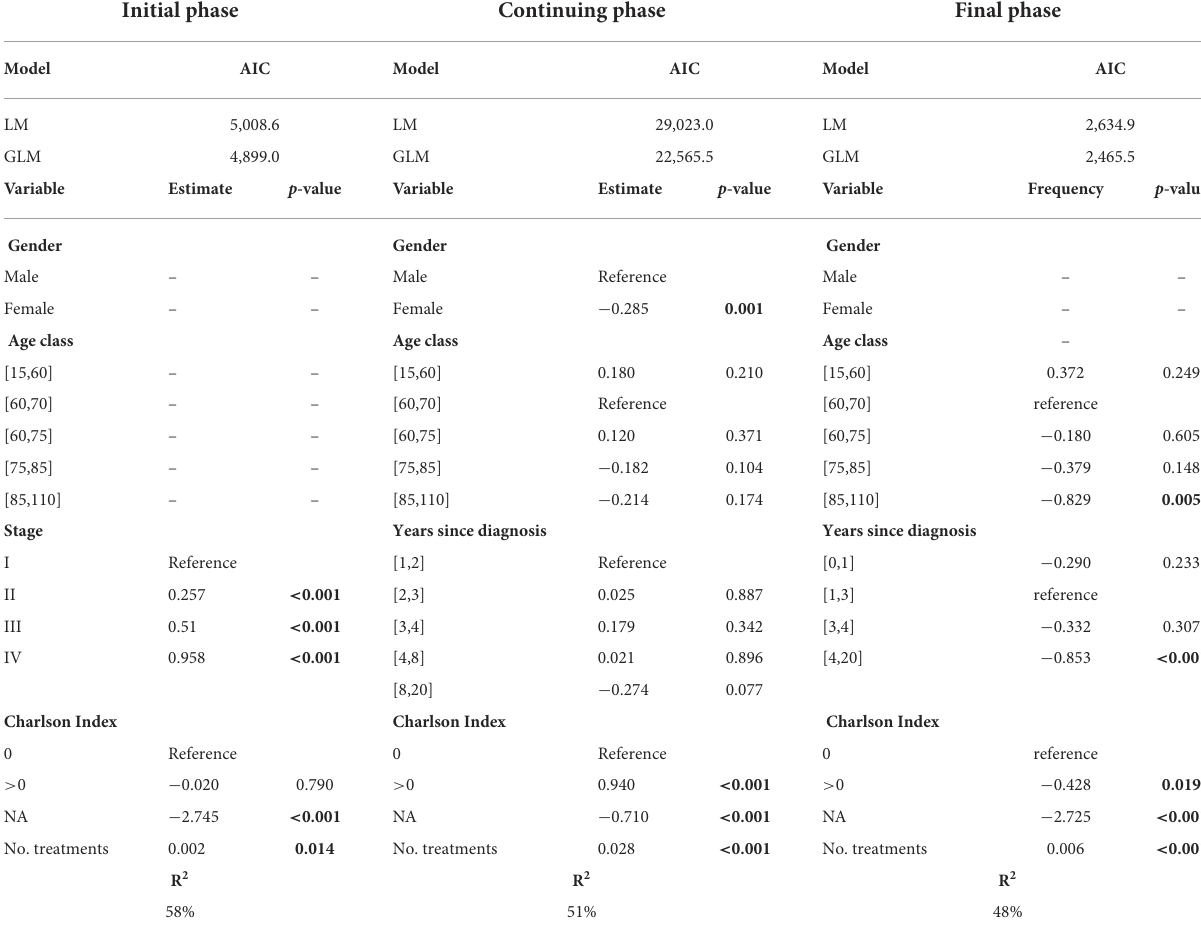
TABLE 2 AIC values for the LM and Gamma-GLMs estimated on the total annual costs data, regression coefficient estimates for the optimal Gamma GLM and corresponding R 2 values, by phase of